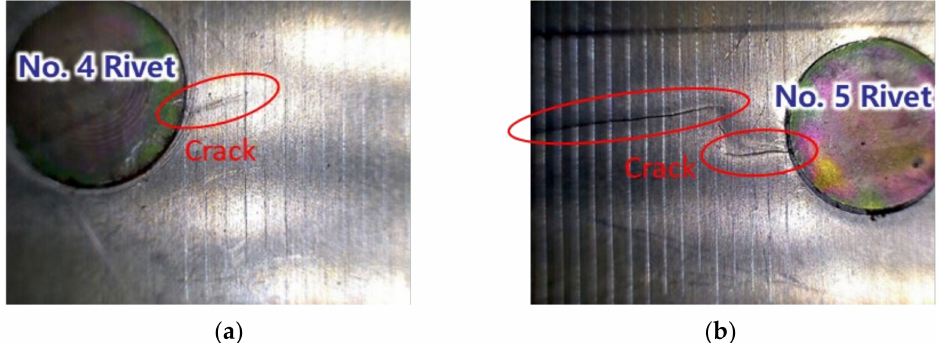
Figure 7. Fatigue cracks of the lap joint structure: ( a ) Fatigue crack just occurs at No. 4 rivet;